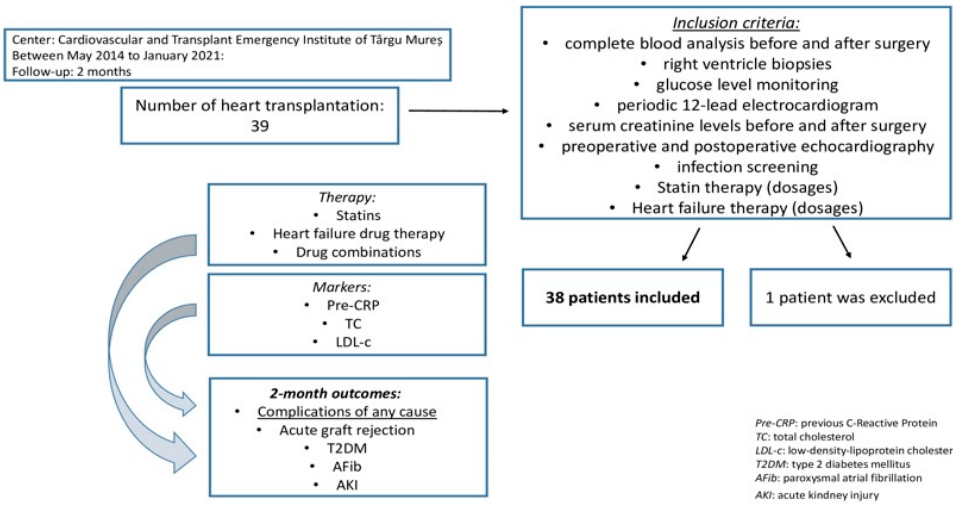
Figure 1. Inclusion criteria and study design.